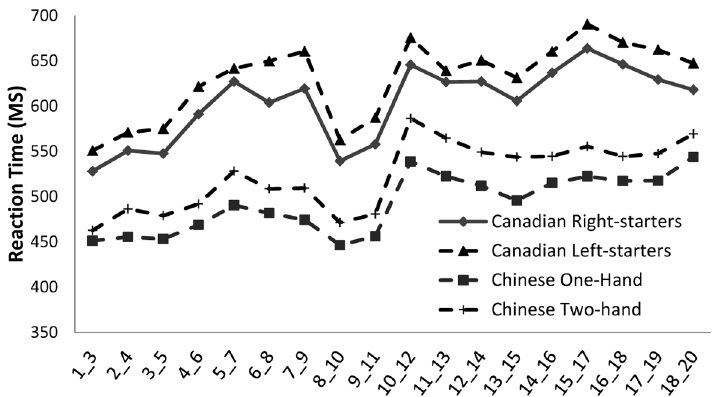
Figure 3. Raw reaction-time scores across comparisons.